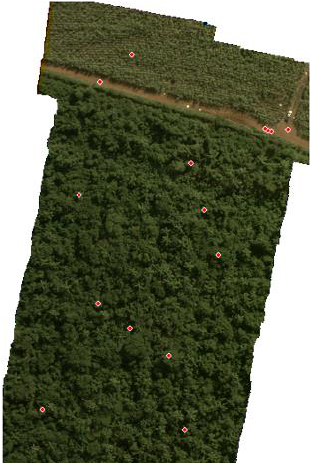
Figure 3. Study area and check points used to evaluate the different radiometric resolutions